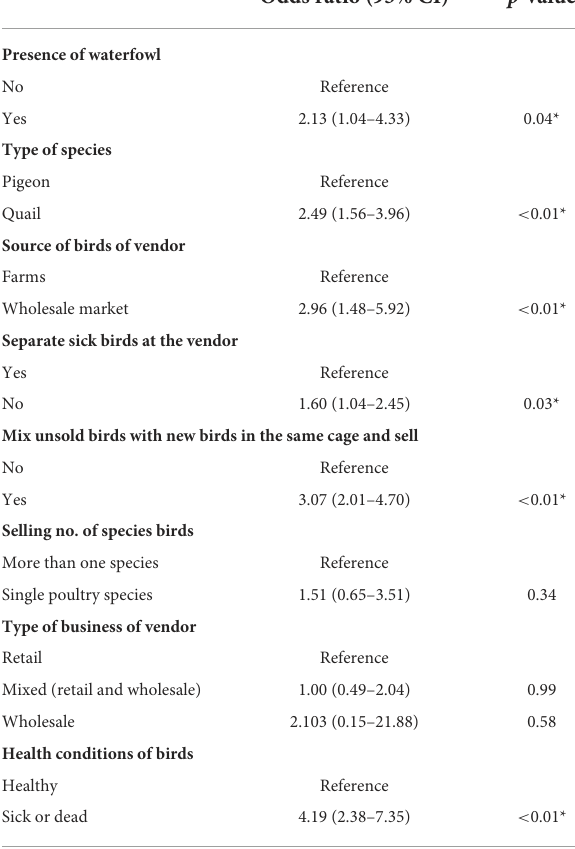
TABLE 3 Bio-security practices associated with AIV circulation (results from mixed-effect logistic regression model) T, † . Odds ratio (95% CI) p